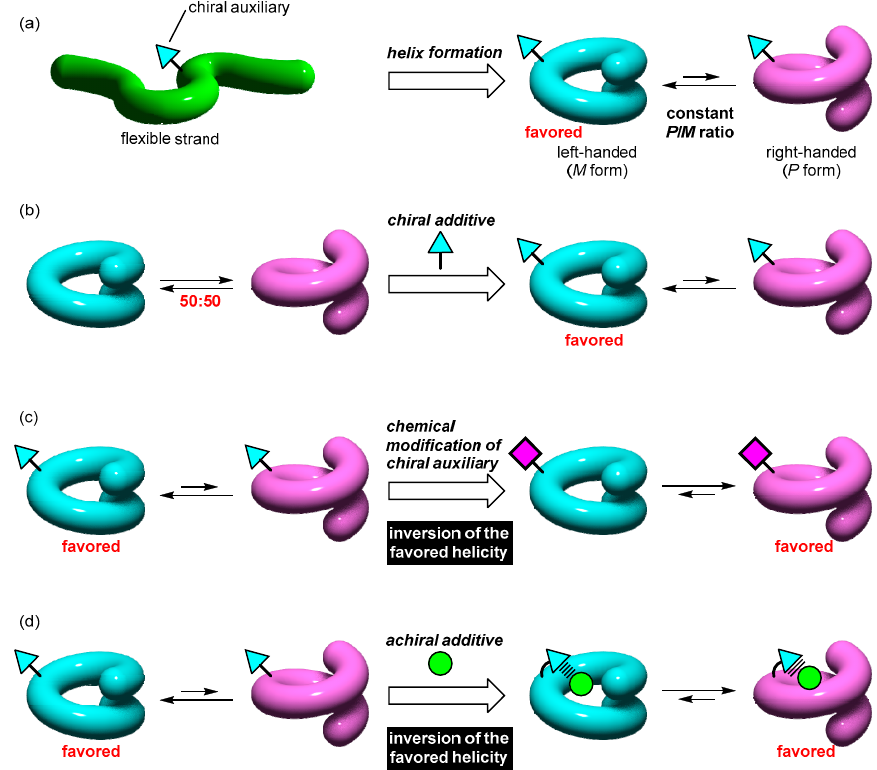
Figure 4. Typical strategies for dynamic helicity control. ( a ) Formation of a dynamic helical structure from a flexible ligand having a chiral auxiliary (Category A). ( b ) Equilibrium shift from a racemic helix (Category B). ( c ) Helicity inversion using chemical modification of the chiral auxiliary (Category C). ( d ) Helicity inversion using an achiral additive (Category C). The turquoise triangles represent a chiral auxiliary that stabilizes the left ‐ handed forms.